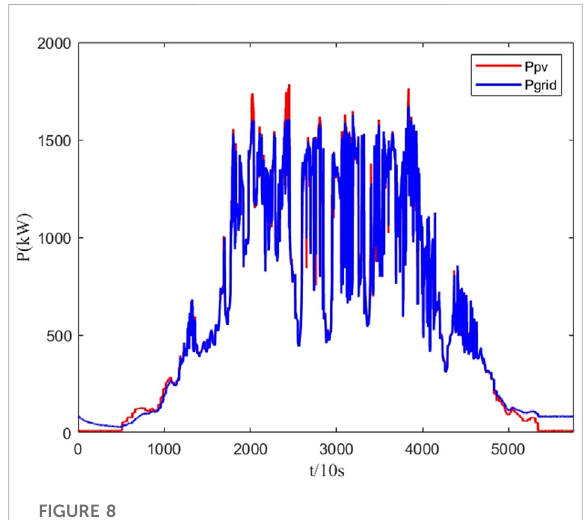
FIGURE 6 Comparison between grid-connected power calculated by SPSA and original output.